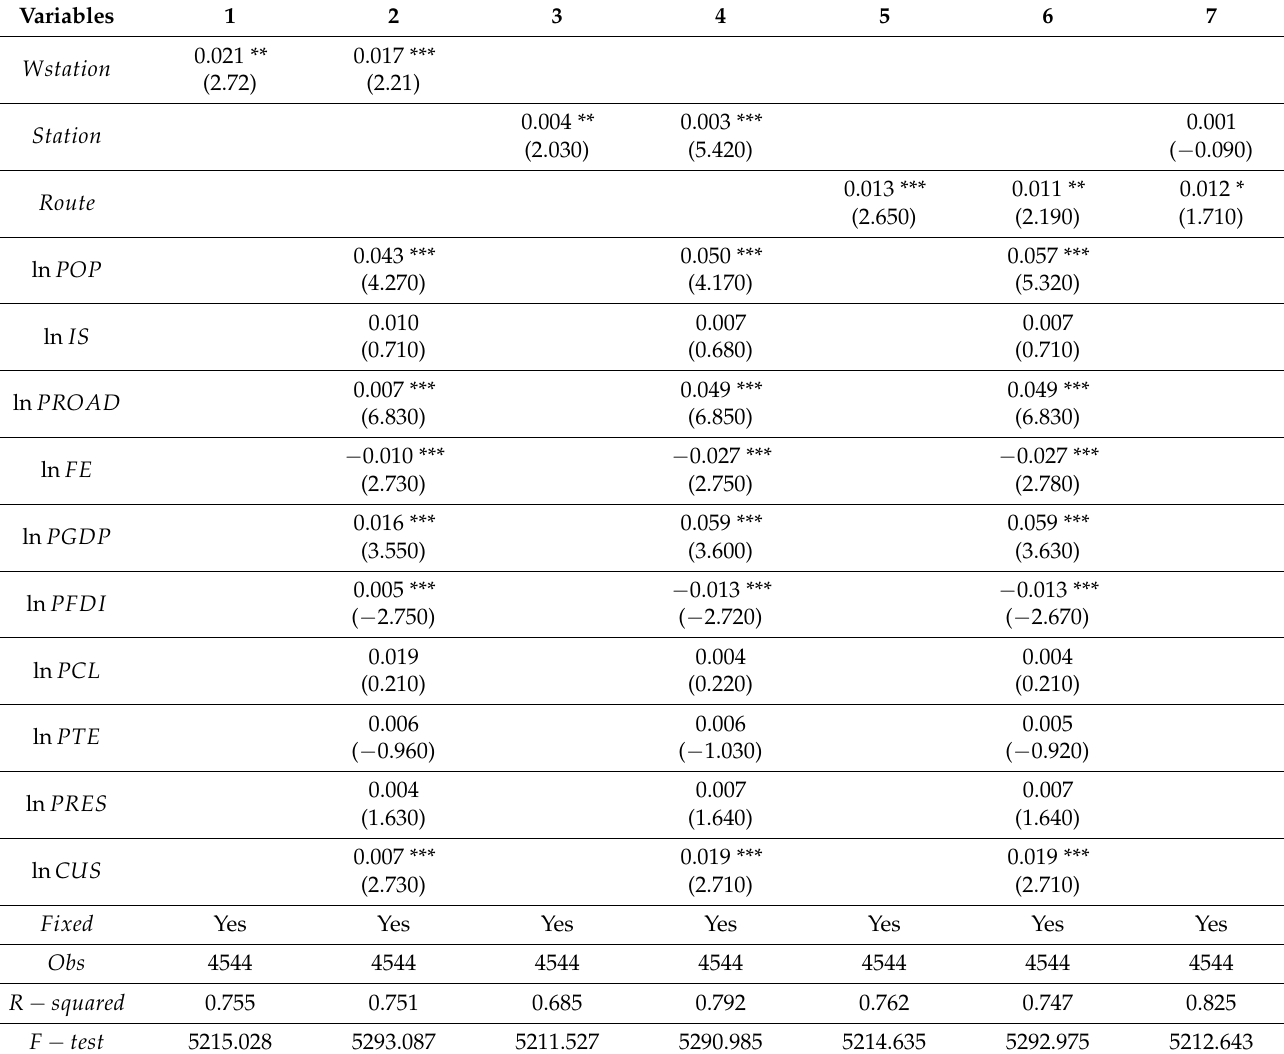
Table 3. Baseline regression results of the DID